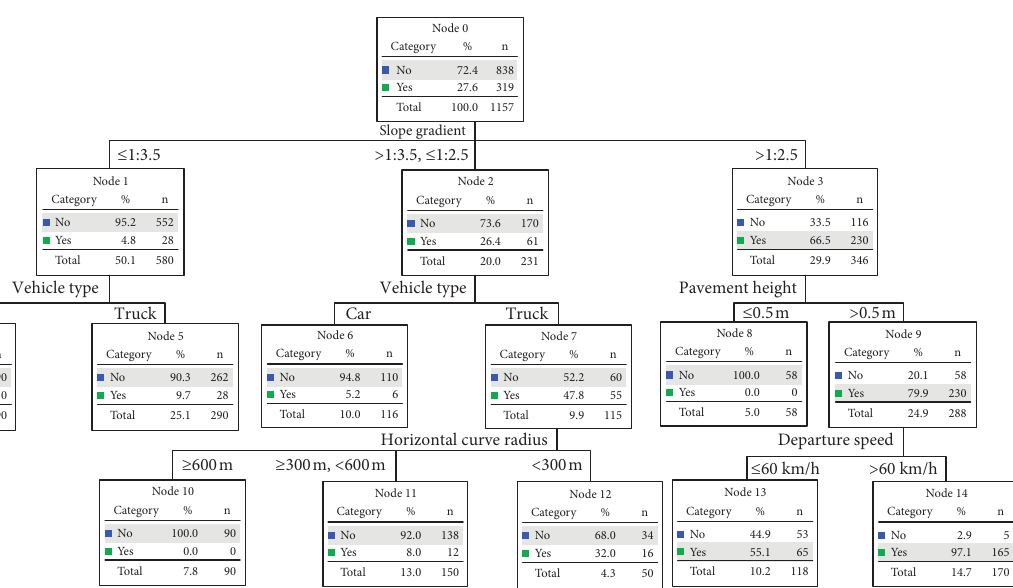
Figure 5: Decision tree model.